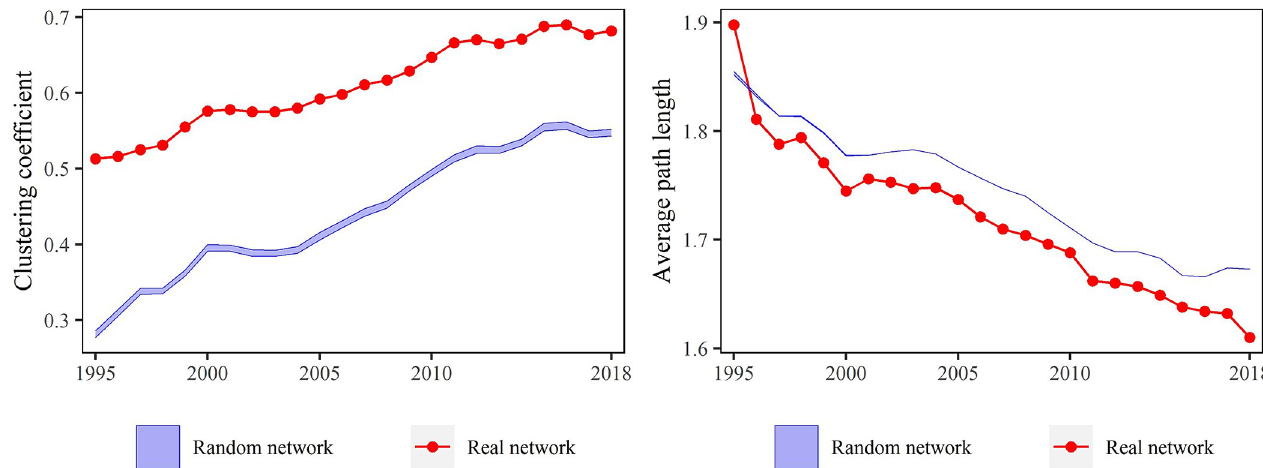
Fig 2. The transitivity (clustering coefficients) and average path length (APL) of the global tourist flows network. The red line represents transitivity (clustering coefficients) and average path length (APL) of real network, whereas the blue shaded area shows the maximum and minimum values of these indices obtained from 1000 random